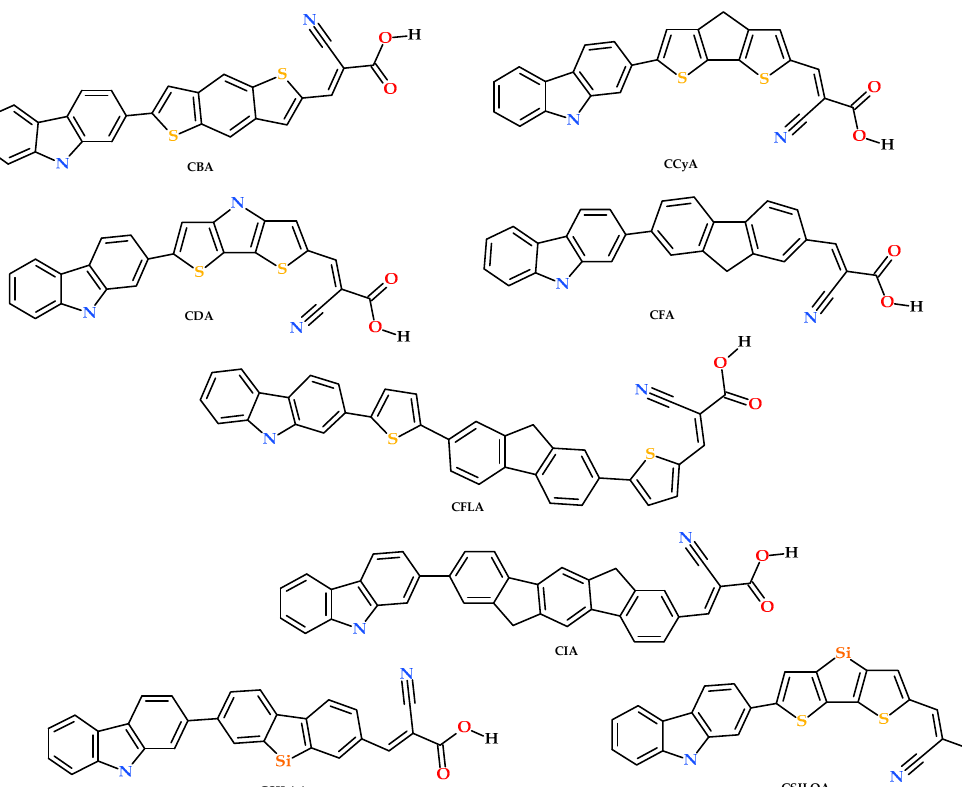
ff erent conjugated π